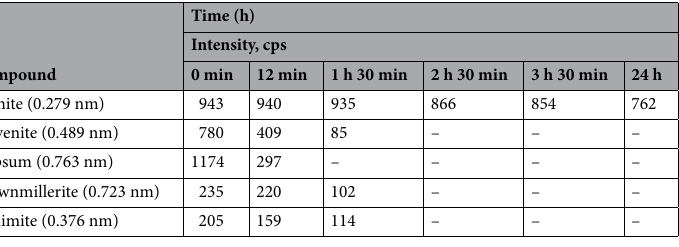
Table 3. Changes of the main diffraction peaks characteristic to the synthesis products of S1-1100 sample.